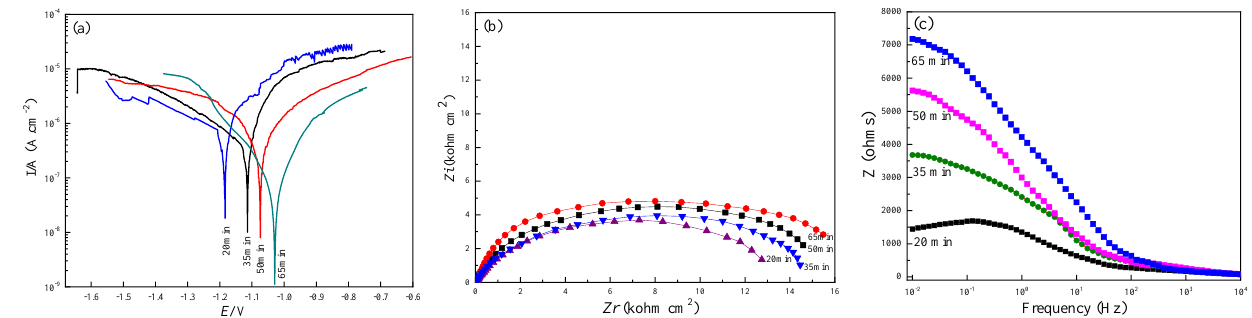
Figure 5. ( a ) Polarization curves; ( b ) Nyquist plots; ( c ) Bode-Z plots. 20 min−1.4 μm; 35 min−1.66 μm; 50 min−1.92 μm; 65 min−2.26 μm. Table 3. Potentio-dynamic polarization parameters of the coatings.